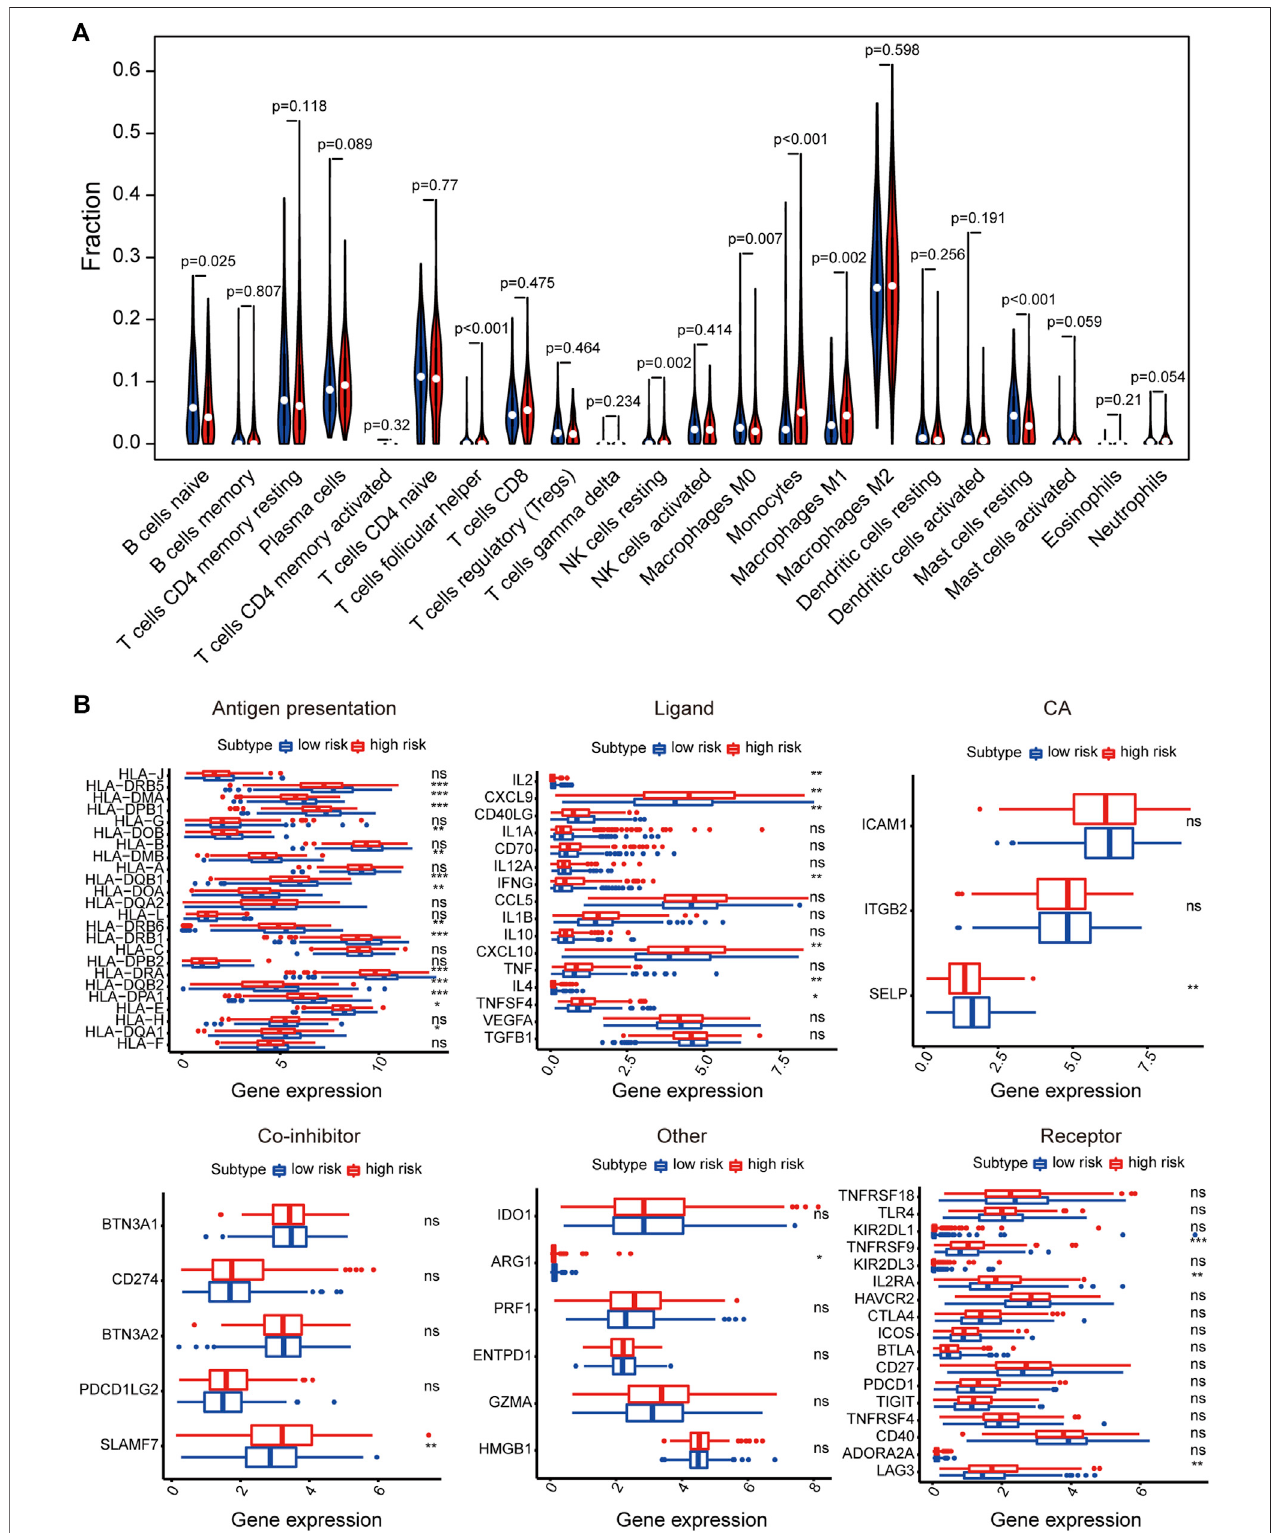
FIGURE 6 | The relationship between signature and immune-related features. (A) The violin plot of the 22 immune cell proportions between high and low-risk groups. (B) Effect of signature on the expression of different immunomodulators. * p < 0.05, ** p < 0.01, *** p < 0.001, **** p < 0.0001.